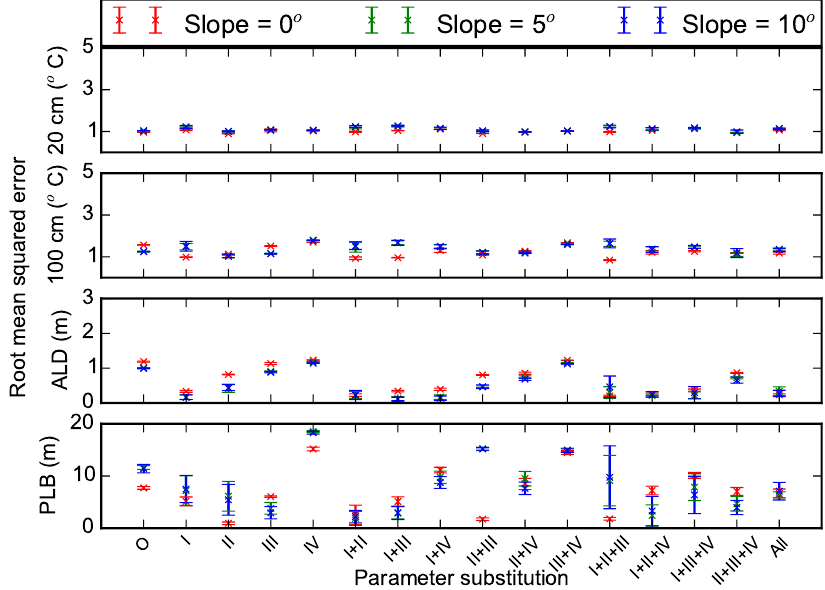
Figure 9. Root mean square errors between measurements and model simulations (with different combinations of measured porosity (I), thermal conductivity (II), hydraulic conductivity (III), and matric potential (IV) substituted for default sand parameters) for 20 and 100cm soil temperatures ( ◦ C), active layer depth (ALD, m), and permafrost low boundary (PLB, m). O and All represent model runs without substitution of default parameters and with all four parameters substituted, respectively. Mean and standard deviation of model simulations with three different soil thicknesses at each slope (0, 5, and 10 ◦ ) are shown.